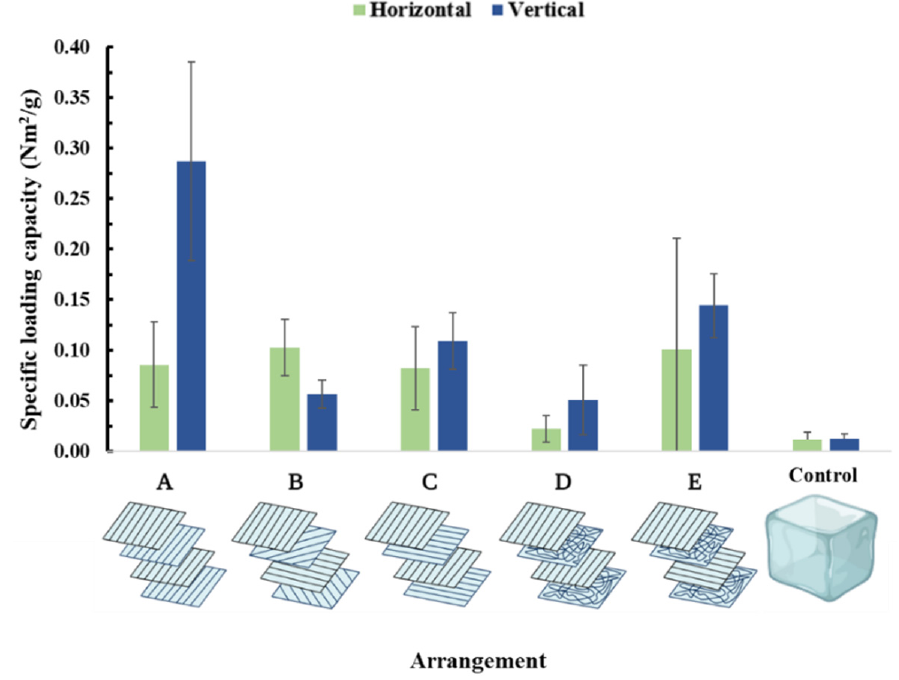
Figure 14. Specific loading capacities of the hydrogel membranes.